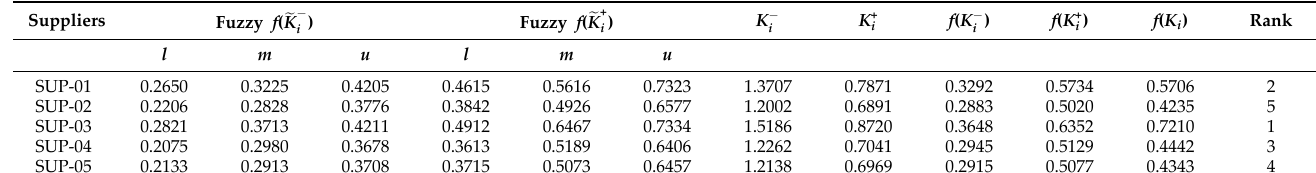
Table 9. Utility functions and final ranking of suppliers.